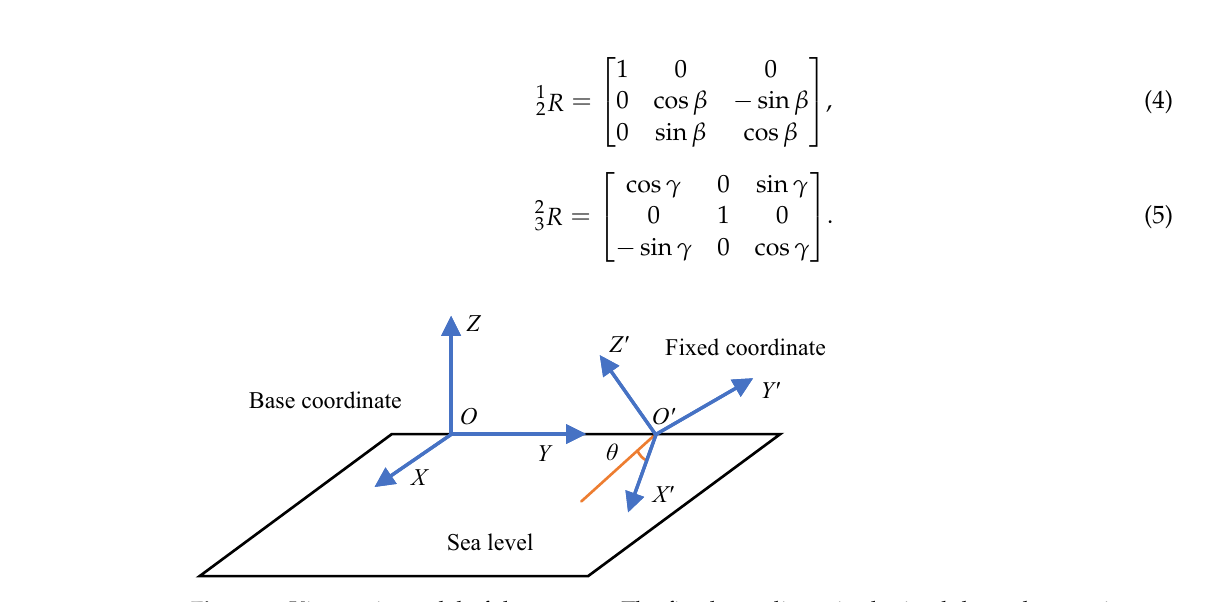
Figure 2. Kinematic model of the camera. The fixed coordinate is obtained through a continuous relative rotation transformation of the base